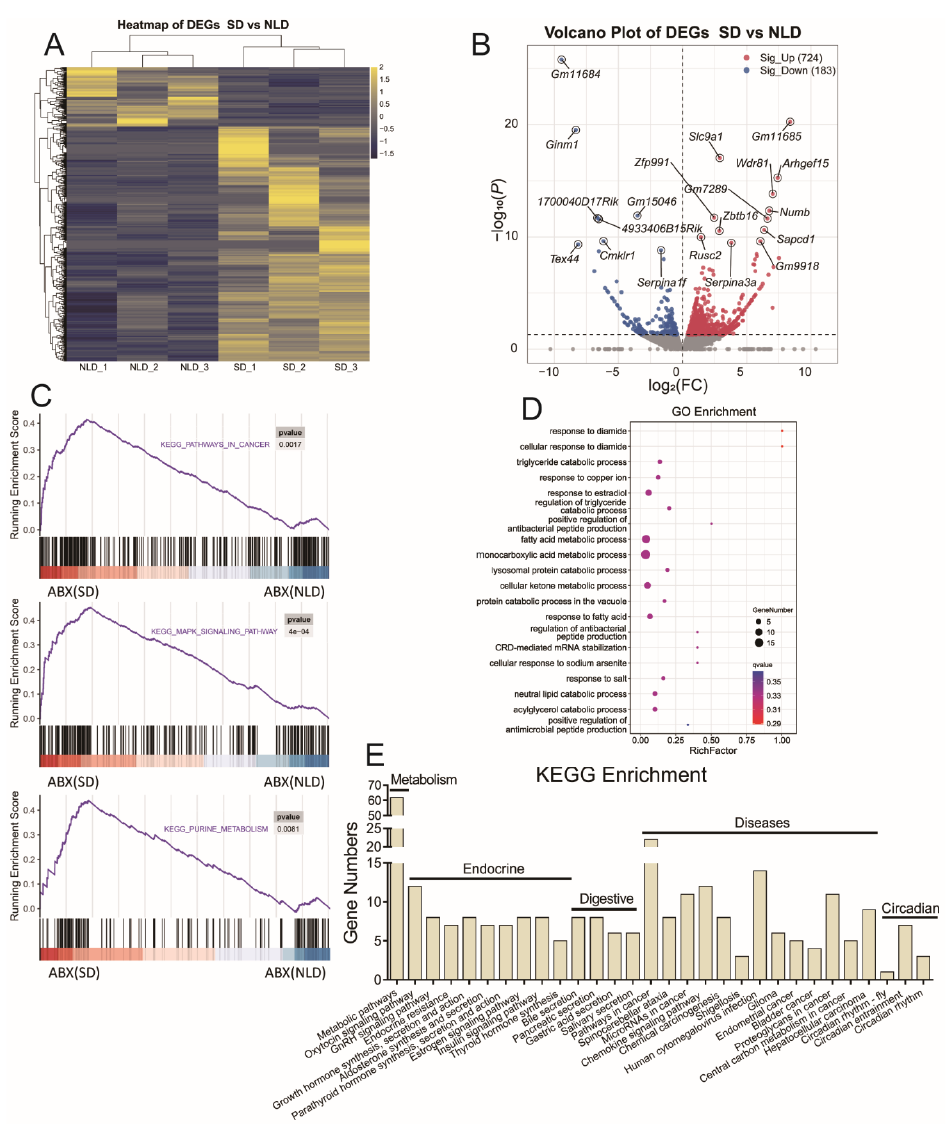
Figure 8. Hepatic transcriptome sequencing profiles and pathway enrichments in ABX mice under NLD and SD. NLD, the antibiotic-treated mice managed under normal light–dark cycle; SD, the antibiotic-treated mice managed under short-day cycle. The differentially expressed genes (DEGs) were screened out by setting p < 0.05 and |log 2 Fold Change| > 1 as threshold. ( A ) The heatmap of the differentially expressed genes; ( B ) the volcano plot of the differentially expressed genes, red dots represent up-regulated and blue dots represent down-regulated; ( C ) GSEA plots for the enrichments of pathways in cancer, MAPK signaling pathway, and purine metabolism; ( D ) Gene Ontology (GO) functional analysis of the significantly expressed genes; ( E ) KEGG functional analysis of the significantly expressed